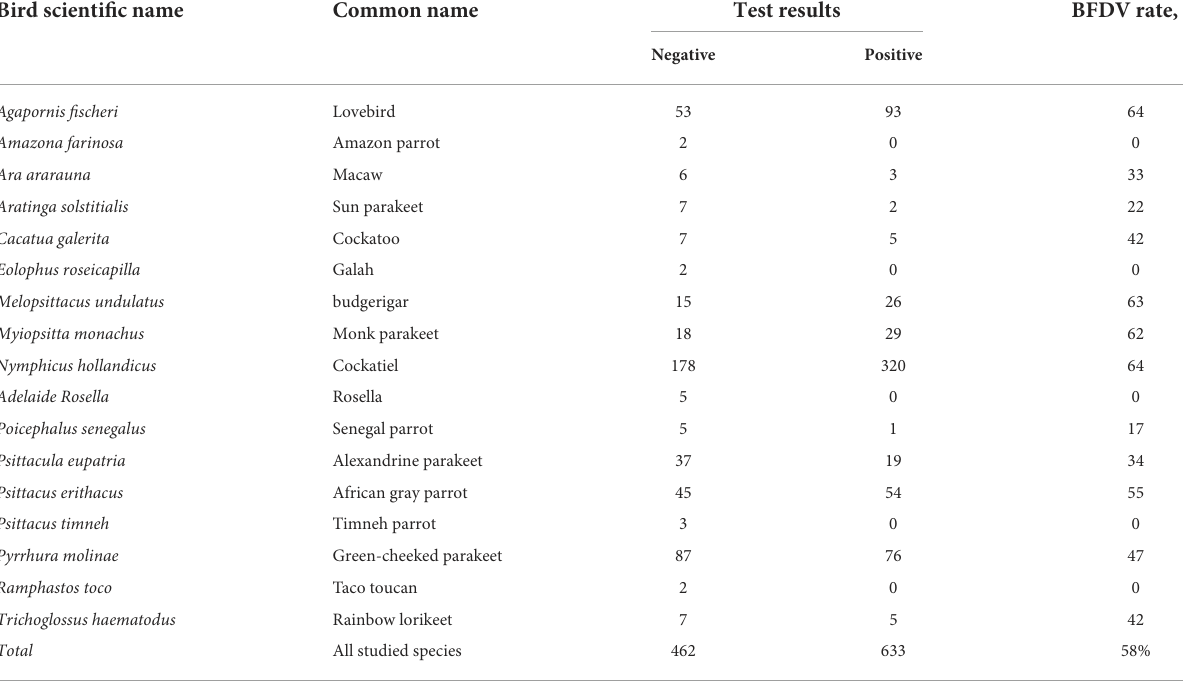
TABLE 2 Results for PCR screening of different species for the beak and feather disease virus